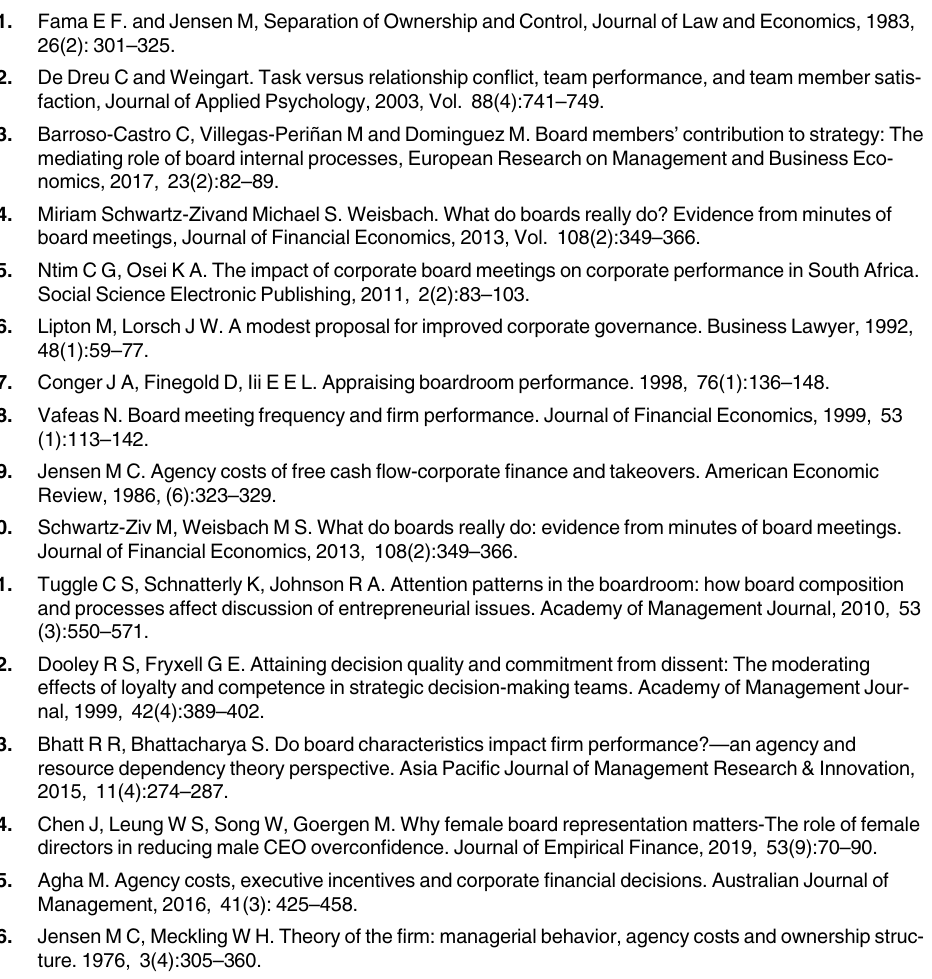
S2 Table. Nonlinear regression results of the number of board meetings and overinvest-